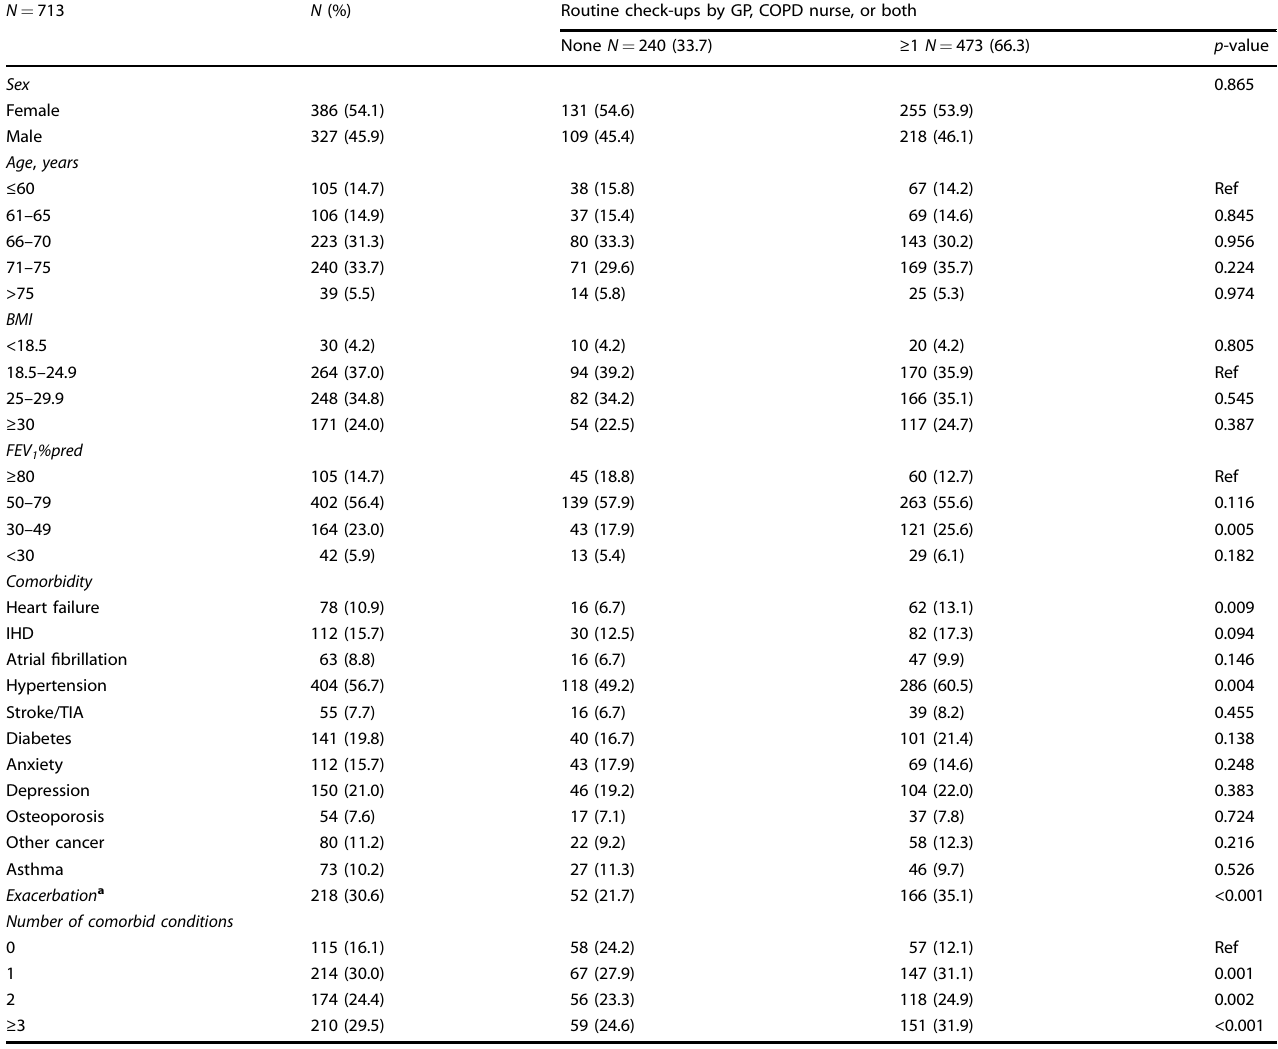
Table 1. Patient characteristics.